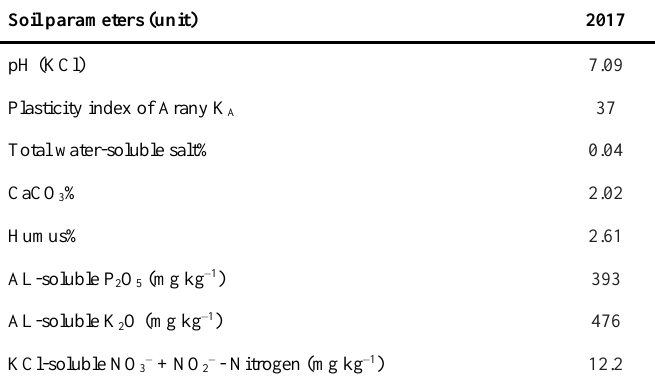
Figure 1. Ecological conditions of the experimental field. Table 2. Soil analysis of the experimental